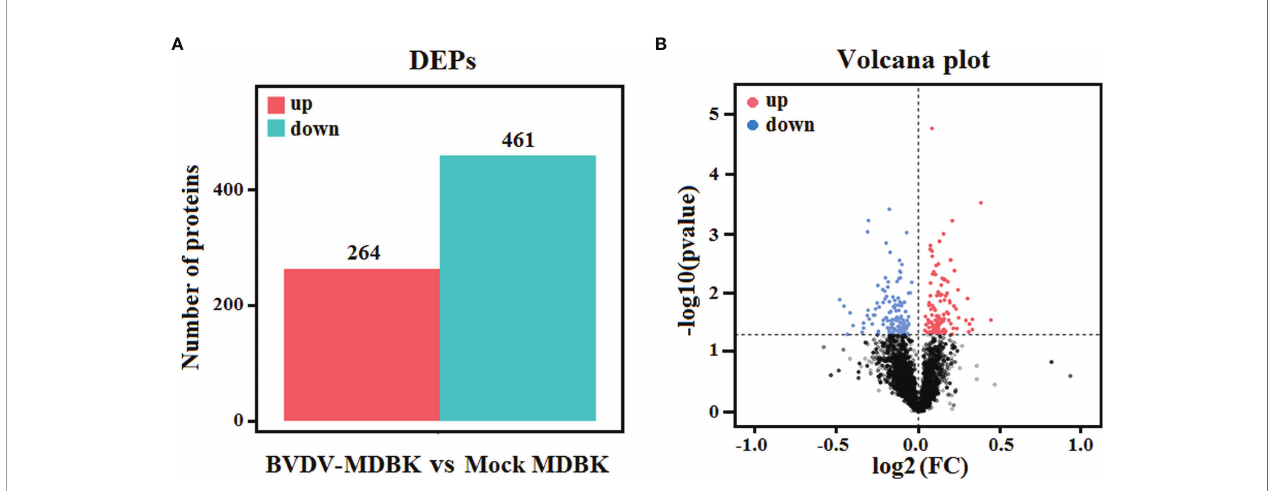
FIGURE 4 | (A) Statistics for the DEPs in iTRAQ-based proteomics data for BVDV-infected MDBK cells compared to mock-infected MDBK cells. The red histogram represents the number of up-regulated DEPs, and the blue histogram represents the number of down-regulated DEPs. (B) Volcano plot of the DEPs. The red dots represent signi fi cantly up-regulated proteins, blue dots represent signi fi cantly down-regulated proteins, and black dots represent insigni fi cantly